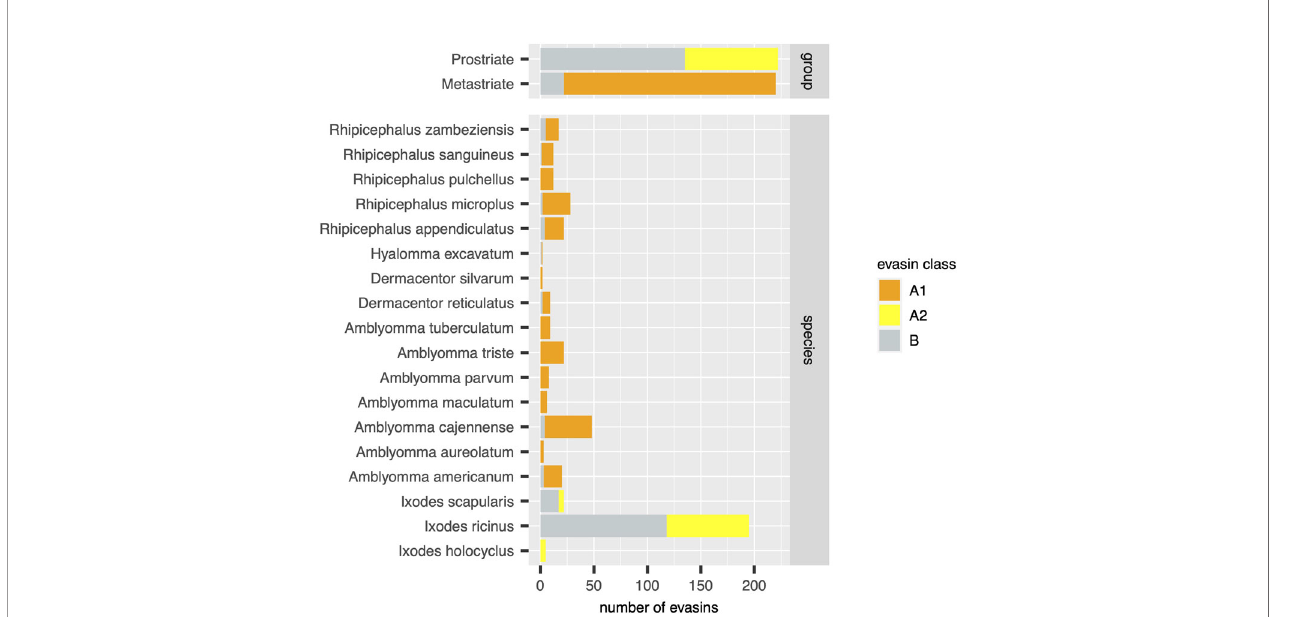
FIGURE 3 | Distribution of evasins and evasin-like proteins in diverse tick species. Stacked bar charts showing the numbers of distinct evasins by class (x-axis, coloured as indicated in the guide) in tick groups (top panel) and in individual tick species (bottom